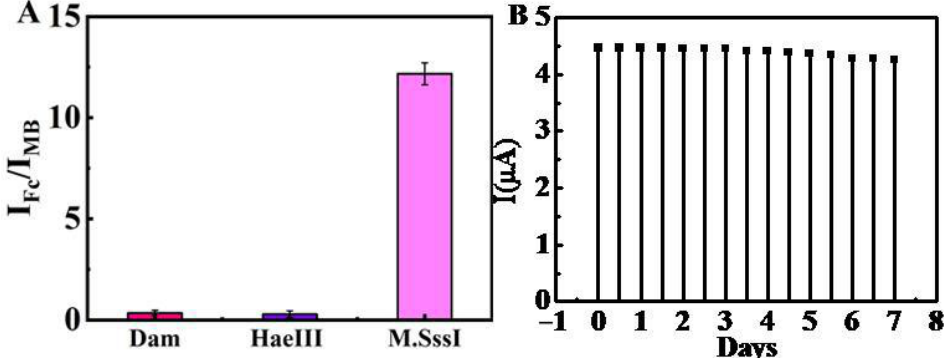
Figure 5. ( A ) Selectivity of the system for M.SssI MTase analysis; Error bars represent standard deviations of three parallel experiments. ( B ) The time dependence of the signal change of the proposed method in the 7 days